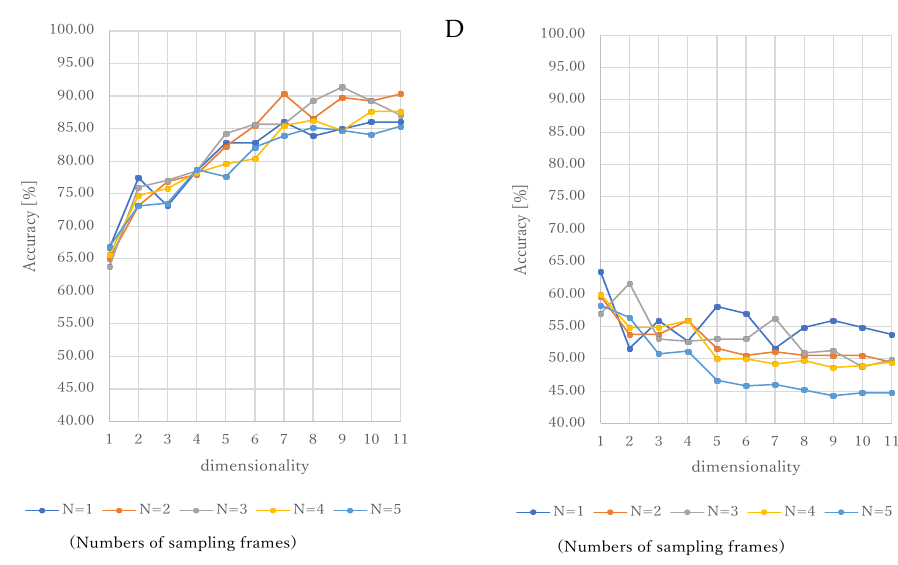
Figure 3. Evaluation results of SVM using four kernels. ( A ) Linear function. ( B ) Nonlinear RBF. ( C ) Non-linear poly function. ( D ) Nonlinear sigmoid function.